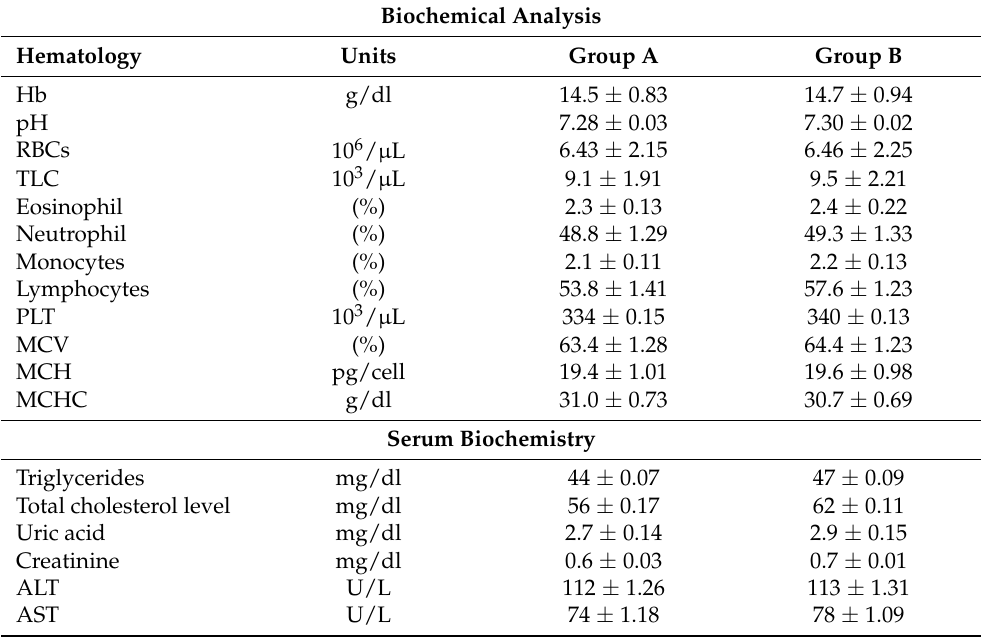
Table 8. Biochemical assessment of different parameters for acute toxicity in Group A and Group B. Biochemical Analysis